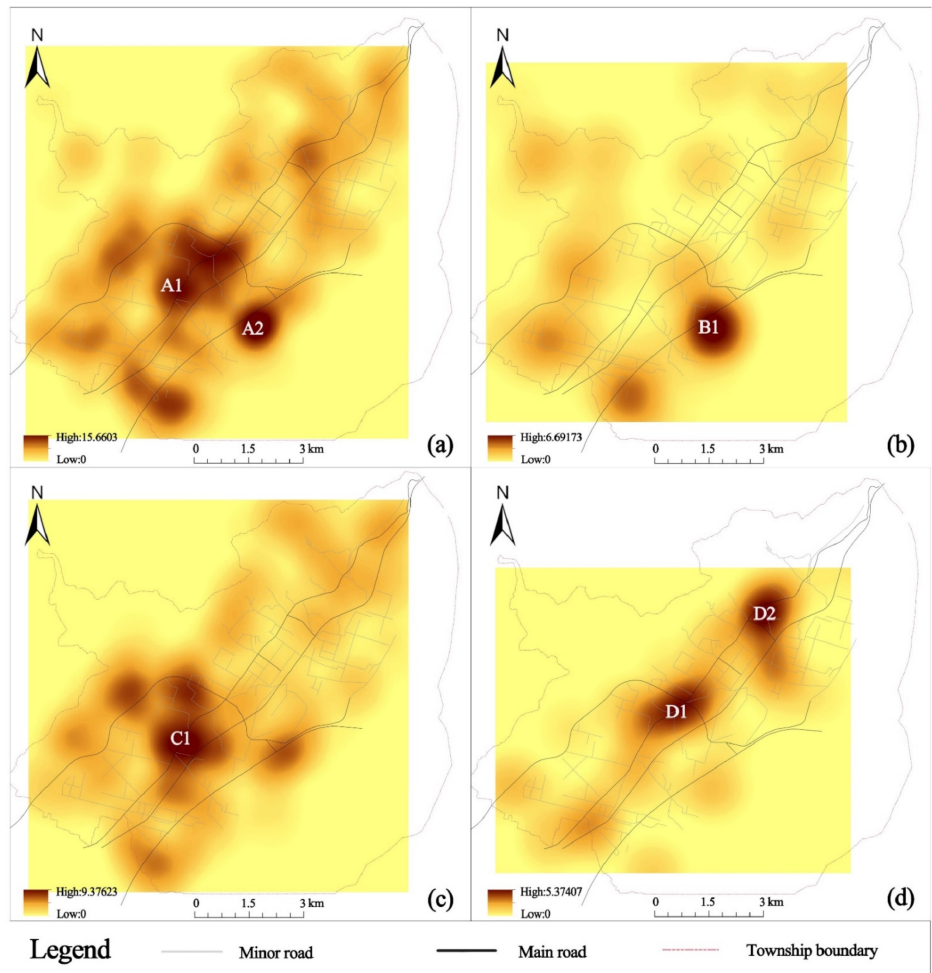
Figure 8. Distribution of nuclear density of urban inefficient land use sites in Longmen. (( a ). Inef- ficient land; ( b ). Inefficient residential land; ( c ). Inefficient industrial land; ( d ). Inefficient commer- cial